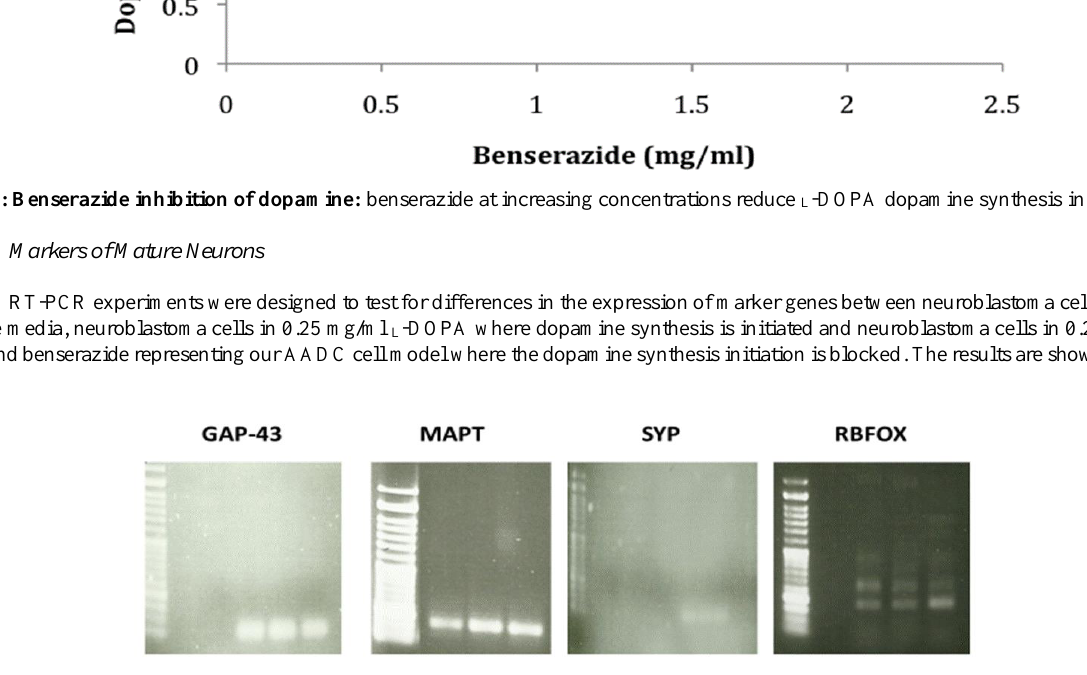
Figure 7: RT-PCR bands of markers of mature neurons: GAP-43 bands at 70 bp; MAPT bands at 154 bp; SYP bands at 63 bp; RBFOX with non-specific bands, one of it the target protein at 178 bp. All agarose gels were loaded with RT-PCR products in the order Lane 1: un- treated cells, Lane 2: cells treated with L -DOPA, Lane 3: cells treated with L -DOPA and benserazide.